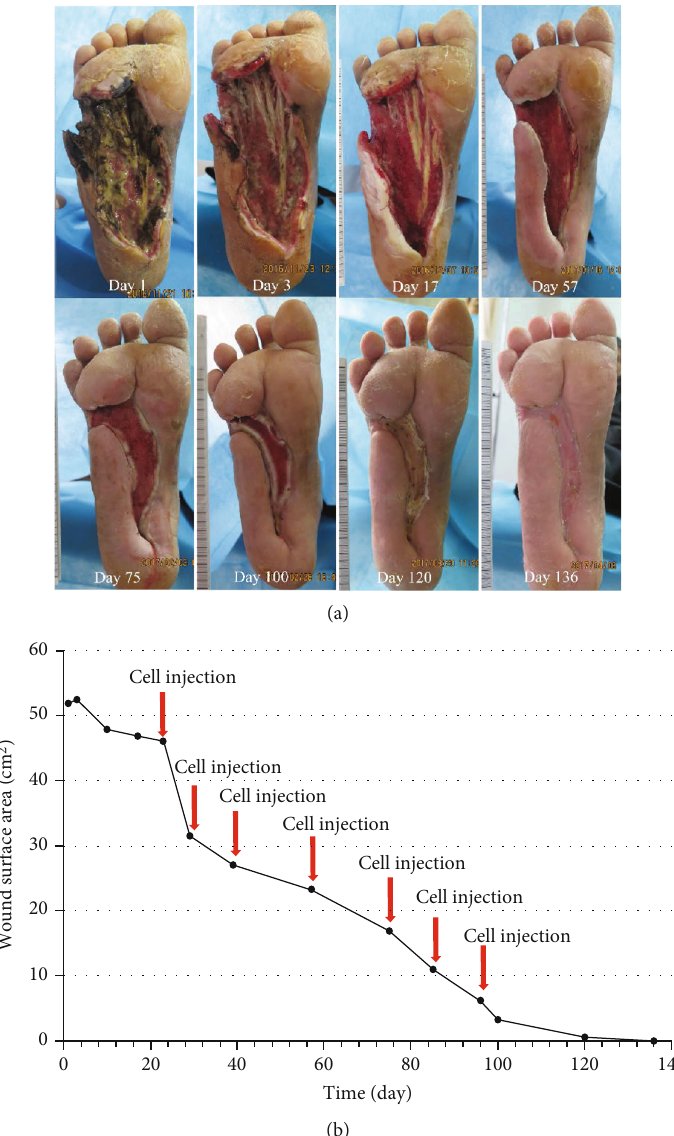
Figure 4: Photographs of ulcer before and after treatment (a) with depiction of wound surface area (b). Patient #11, a 47-year-old man with a 10-year history of type 2 diabetes, presented with infection of his right foot (Wagner 4), which was present for two months; the wound area was 52.39 cm 2 after